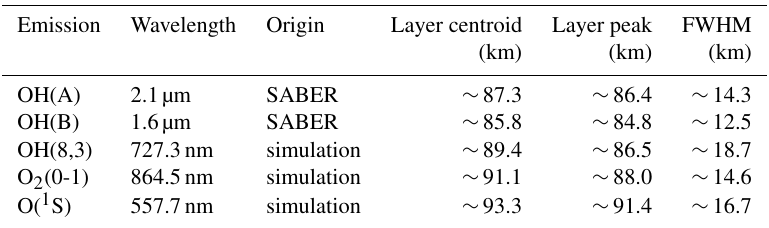
Figure 3. Individual TIMED/SABER satellite orbits near Kühlungsborn during the SIMONe–2018 campaign. The colored lines represent the location where vertical atmospheric profiles were measured, not the actual satellite locus. The day and time of each orbit is indicated in the legend. The field of view of 512 × 512km 2 of the airglow camera projected at ∼ 95km is indicated by the O( 1 S), TD image mapped onto geographic coordinates, while the ellipse indicates the field of view of the MSMR system. The white crosses indicates the coordinates of the imager system in the Kühlungsborn observatory and the meteor radar system. Table 2. Centroid, peak, and FWHM of the OH, O 2 , and O( 1 S) layers measured and calculated using TIMED/SABER data collected near Kühlungsborn during the SIMONe–2018